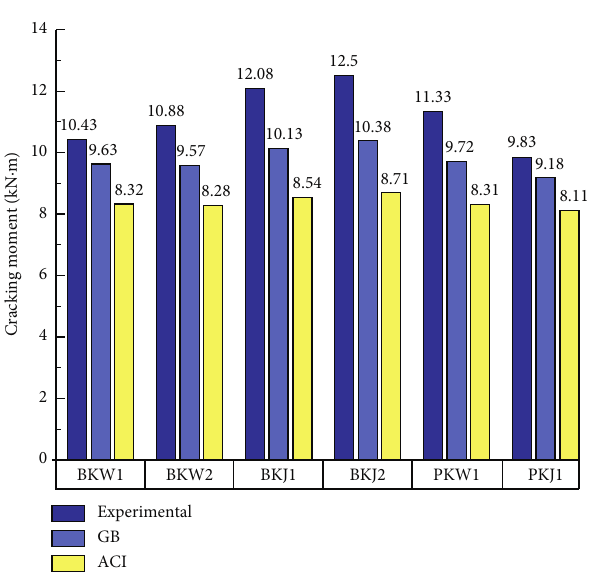
Figure 9: Comparison between experimental and theoretical cracking moments.